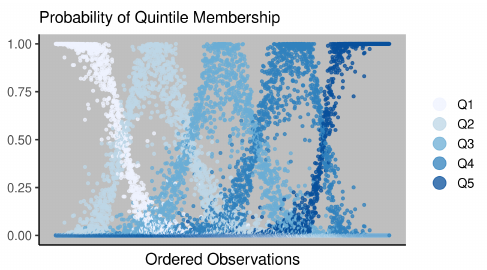
Figure 11. Uncertainty of quintile membership for county ICE observations. Results are derived from the joint probability distribution of the auto-Gaussian ICE data